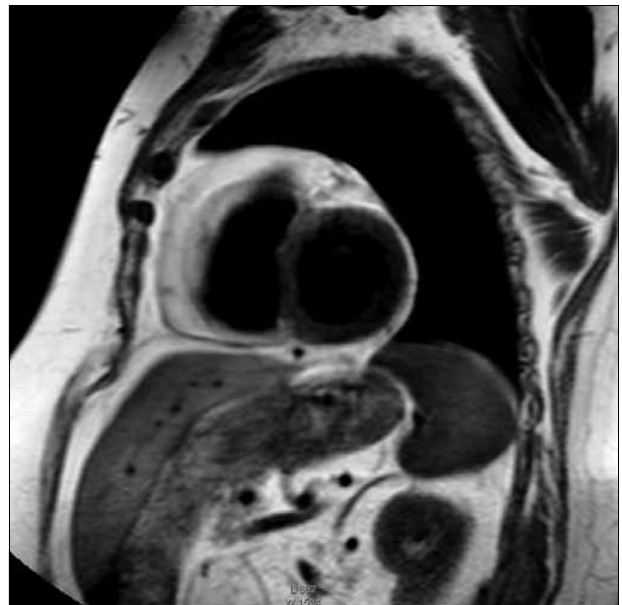
Fig. 3. Short axis dark blood T1 TSE.